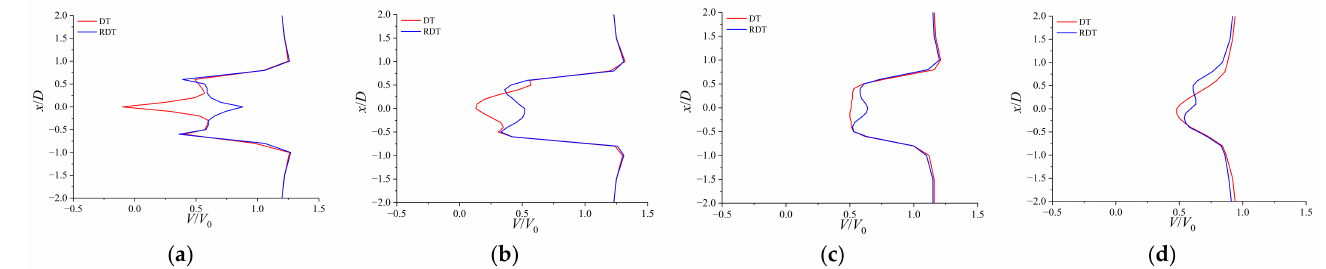
Figure 15. Profiles of mean streamwise velocity for TSR = 4.0 at different streamwise locations in the central x - z plane: ( a ) z / D = 0.5; ( b ) z / D = 1.0; ( c ) z / D = 3.0; ( d ) z / D = 5.0.